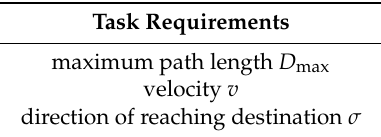
Table 1. Constraints of launching